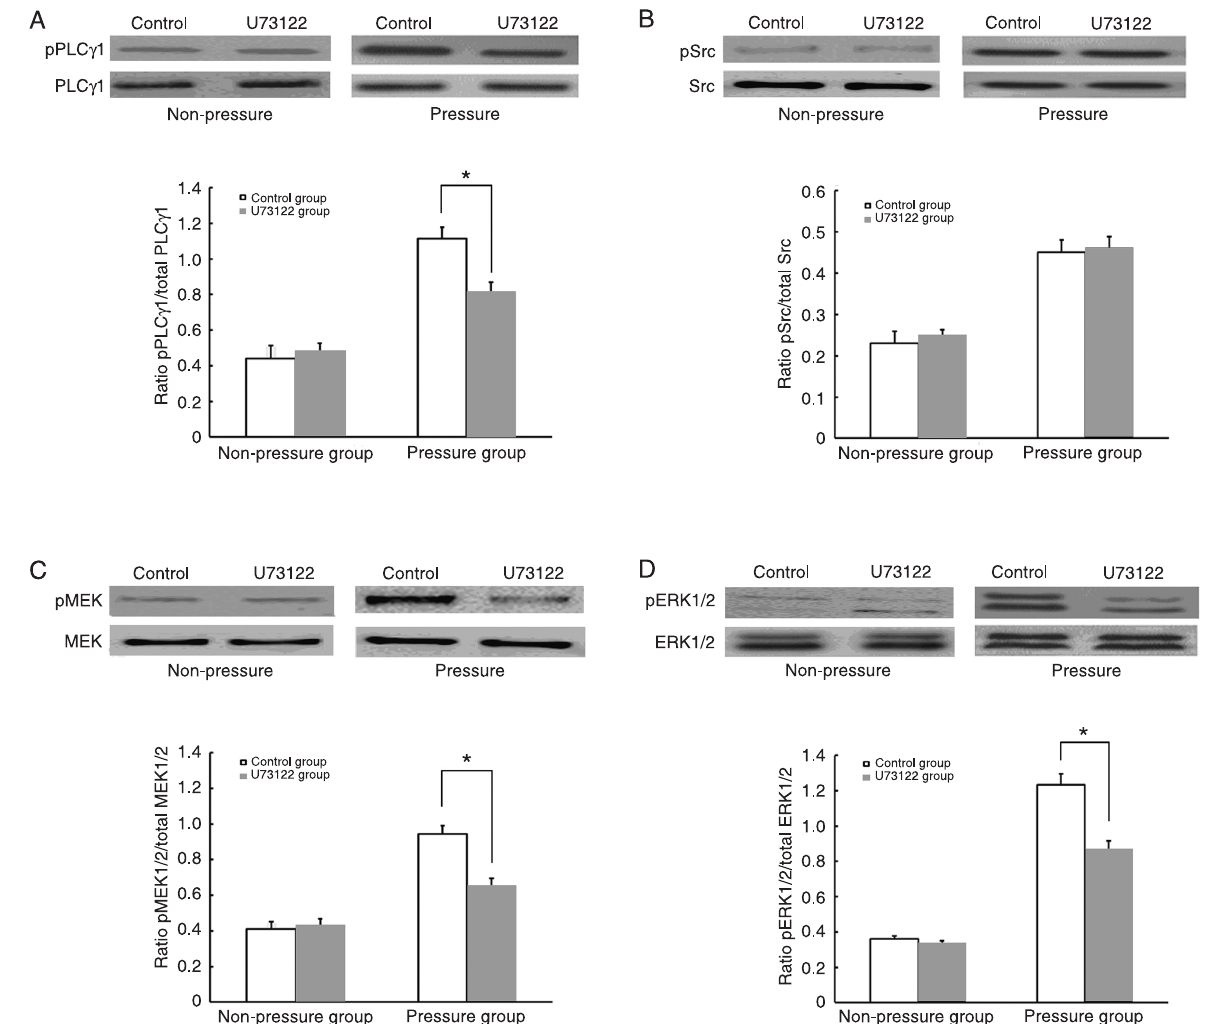
Figure 5. Effect of U73122 on the expression and phosphorylation of PLCγ1, Src, MEK1/2, and ERK1/2 under conditions of periodic me - chanical stress. After pretreatment with DMSO or PLCγ1 inhibitor (U73122), rat chondrocytes were cultured in vitro for 1 h under static conditions or conditions of periodic mechanical stress. The expression and phosphorylation levels of PLCγ1, Src, MEK1/2, and ERK1/2 were detected by Western blotting. A , The total amount of PLCγ1 served as the control. The images above the histogram are represen - tative results of Western blotting. The phosphorylation levels of PLCγ1-Tyr 783 in the U73122 group were significantly reduced relative to control in chondrocytes in response to periodic mechanical stress (N = 5, *P < 0.05, Student unpaired t -test). B , The total amount of Src served as the control. The images above the histogram are representative results of Western blotting. The phosphorylation levels of Src-Tyr 418 in the U73122 group were not altered relative to those in the control group in chondrocytes in response to periodic mechanical stress (N = 5, P > 0.05, Student unpaired t -test). C , The total amount of MEK1/2 served as the control. The images above the histogram are representative results of Western blotting. The phosphorylation levels of MEK-Ser 217/221 in the U73122 group were significantly decreased relative to those in the control group in chondrocytes in response to periodic mechanical stress (N = 5, *P < 0.05, Student unpaired t -test). D , The total amount of ERK1/2 served as the control. The images above the histogram are representative results of Western blotting. The phosphorylation levels of ERK1/2-Thr 202 /Tyr 204 in the U73122 group were significantly decreased relative to those in the control group in chondrocytes in response to periodic mechanical stress (N = 5, *P < 0.05, Student unpaired t